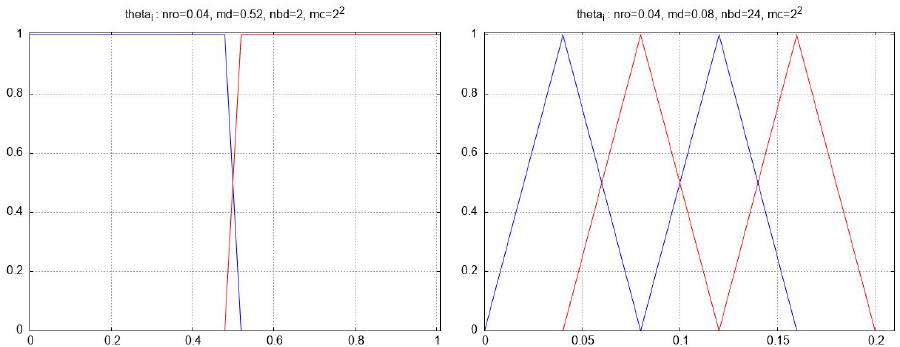
Figure 7. Sections in the direction of a coordinate axis passing through the center of the functions of a unity partition: 2 2 subdomains ( left ) and 24 2 subdomains ( right ).